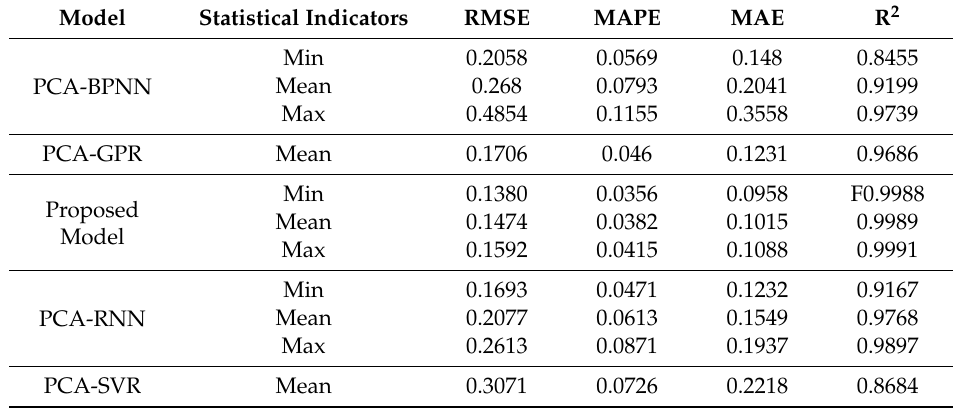
Table 6. Evaluation index of prediction